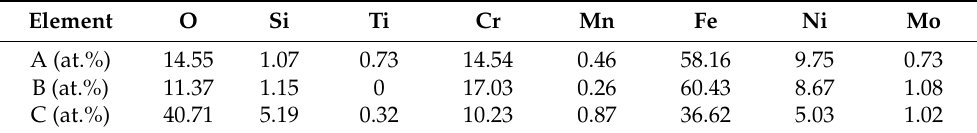
Figure 9. SEM images of the wear track topography of the samples with different Ti ion-implanted doses: ( a ) un-implanted, ( b ) 3.0 × 10 16 ions/cm 2 , ( c ) 1.0 × 10 17 ions/cm 2 , ( d ) 1.0 × 10 18 ions/cm 2 , and ( e ) 1.7 × 10 18 ions/cm 2 . Table 1. EDS analysis result of wear track topography.